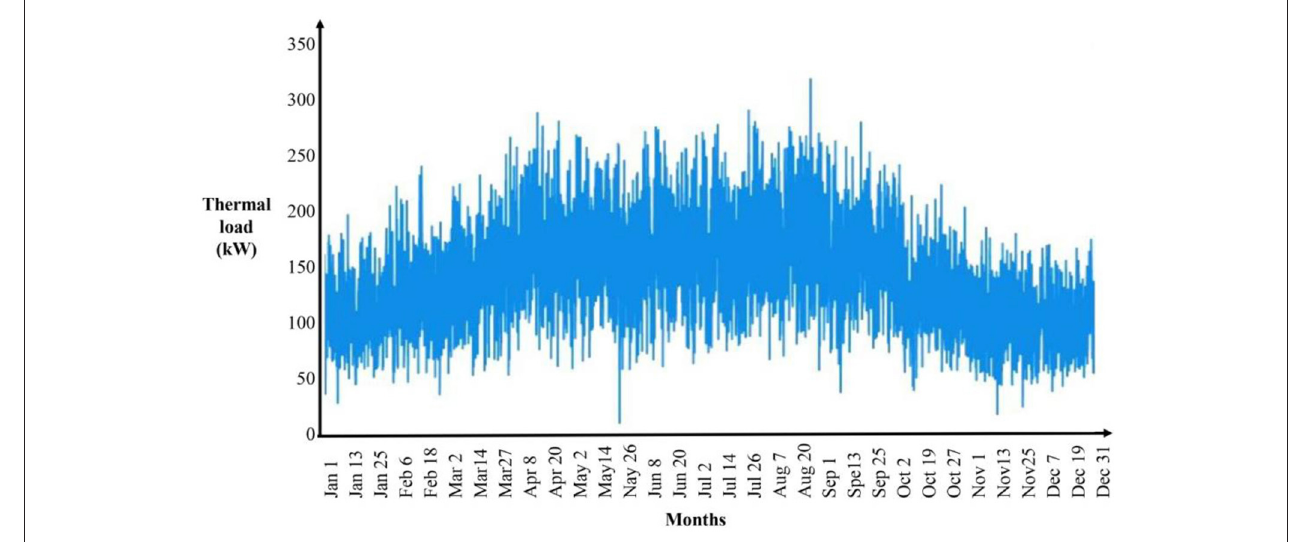
FIGURE 9 | Daily thermal load consumption of hospital building.